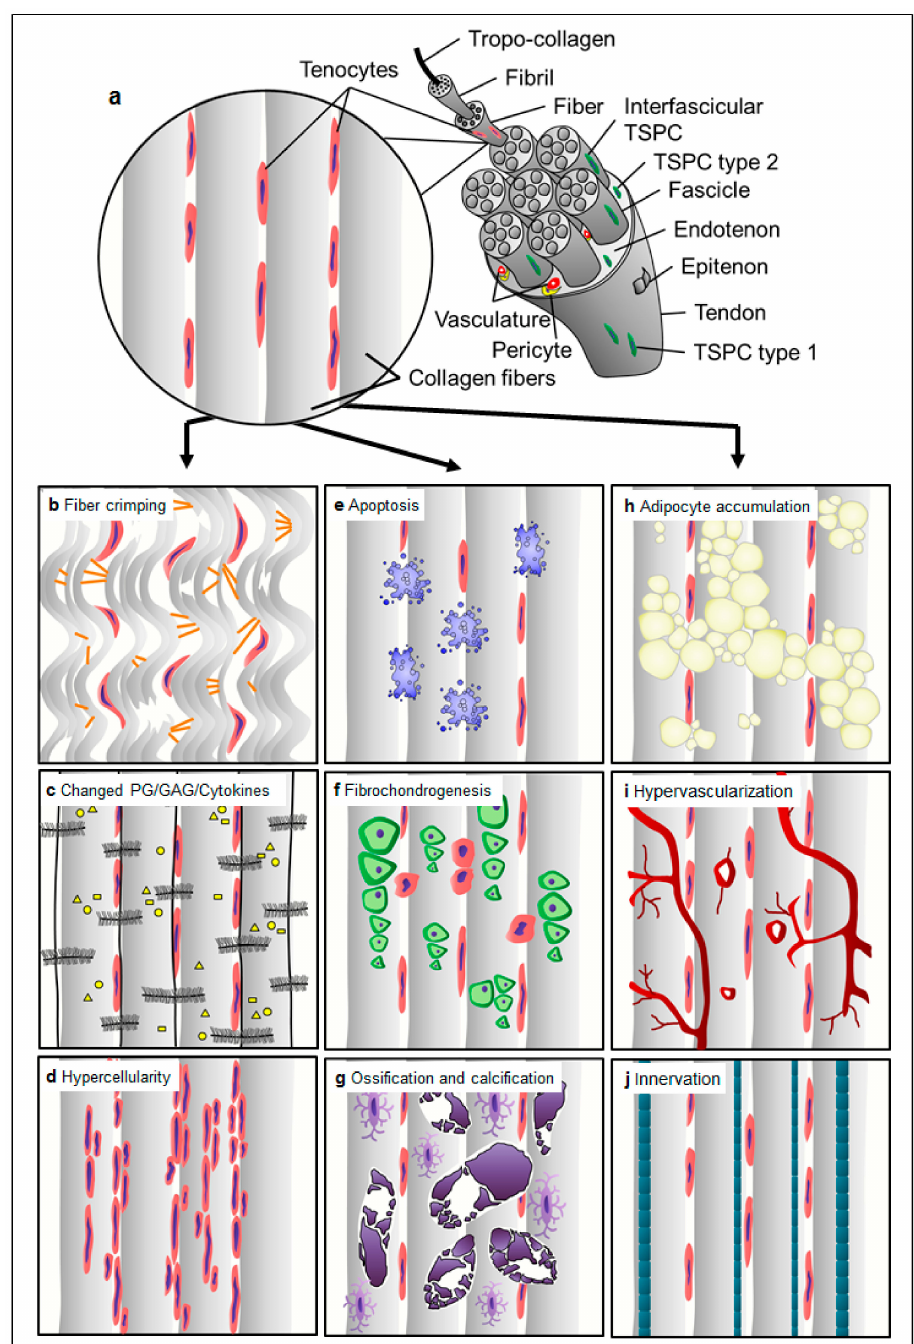
Figure 1. Histopathological changes in tendinopathy. ( a ) Normal tendon tissue, ( b ) fiber crimping and kinking, loosening of collagenous matrix, ( c ) increased proteoglycan (PG) / glycosaminoglycan (GAG) production and changed cytokine profiles, ( d ) hypercellularity, ( e ) apoptosis, ( f ) presence of other cell types such as chondrocytes (fibrochondrogenesis), ( g ) osteocytes (calcification), h) adipocyte accumulation, i) hypervascularization and j) innervation. Based on Järvinen et al. [11]. Loading and compressive forces regulate the production and degradation of ECM whereas proteoglycans enable homeostasis of the tendon tissue. In conclusion, it is important to understand the complex interplay of loading, structural changes and cell response in healthy tissue when considering treatment of injured